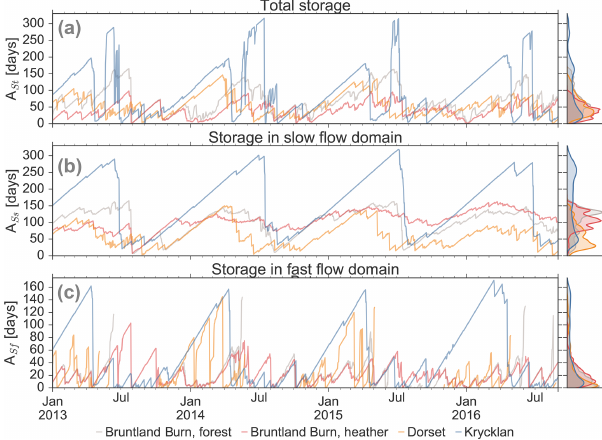
Figure 5. Water ages of (a) total soil water storage ( A St ) , (b) storage in the slow flow domain ( A Ss ) , and (c) storage in the fast flow do- main ( A Sf ) . Note that when storage in the fast flow domain is zero, there is no water age for the storage. For site NH, the spin-up period of 1.5 years was not sufficient to replace the water in the slow flow domain, resulting in continuously increasing water ages for A St and A Ss , which inhibits their analysis (dashed lines). The colour code is according to the four study sites. Density distributions of the water ages are shown for each site on the right-hand